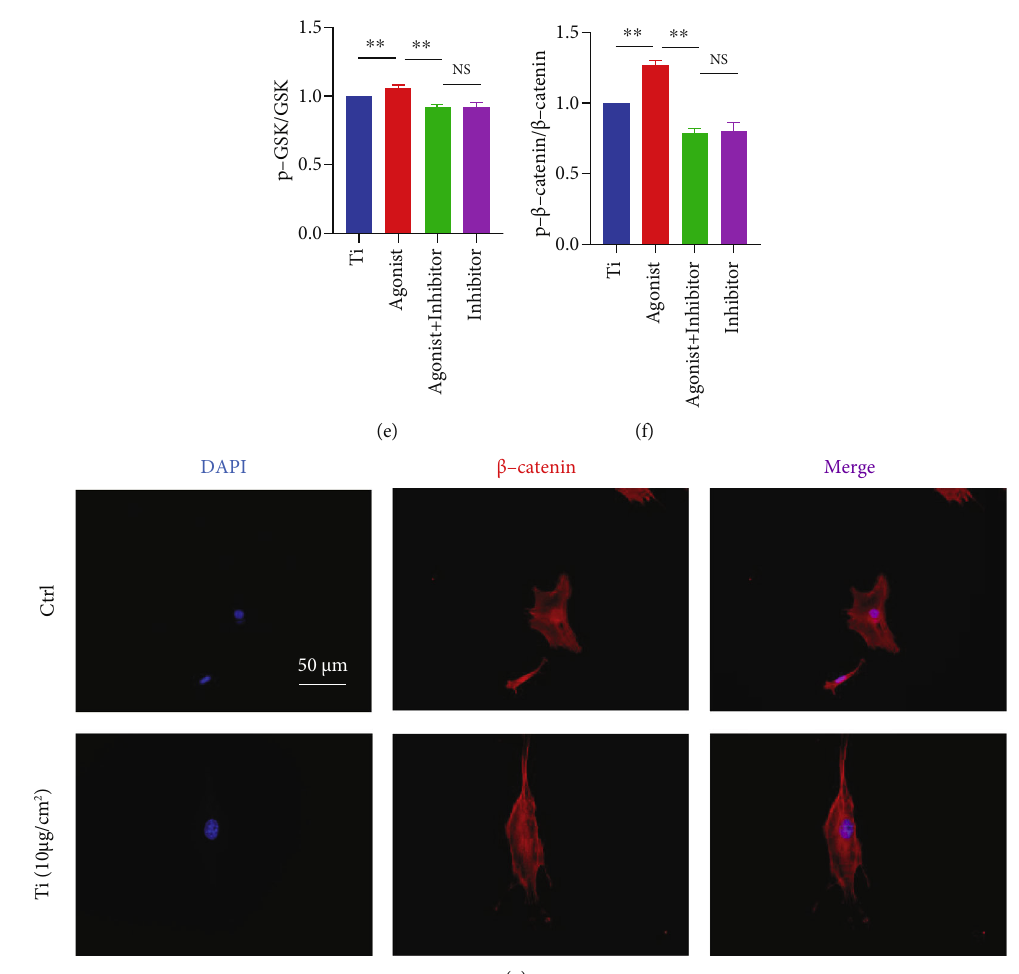
Figure 4: Activation of D1R alleviated the inhibition of osteoblast-related pathway protein expression caused by titanium particles. (a, d) Western blots were probed with antibodies against the osteoblast-associated proteins GSK, p-GSK, β -catenin, and p- β -catenin. (b, c) Temporal analysis of osteoblast-related protein expression. (e, f) Quantitative analysis of the expression of the osteoblast-related proteins GSK, p-GSK, β -catenin, and p- β -catenin in the presence of D1R agonists and/or inhibitors. Note: ∗ P < 0 : 05 and ∗∗ P < 0 : 01 vs. titanium particle inducer group (without treatment with D1R agonists and/or inhibitors). (g) D1R immuno fl uorescence staining. Scale bar: 50 μ